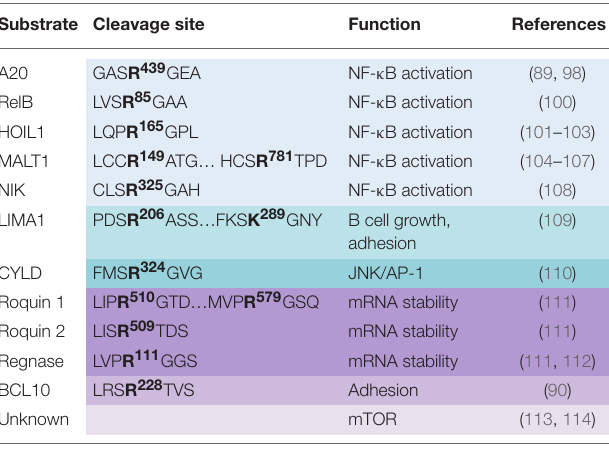
TABLE 1 | MALT1 substrates, cleavage sites and their influence on cellular